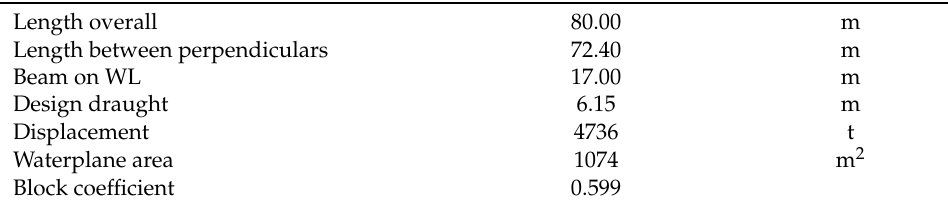
Table 2. Main data of the research ship “Laura